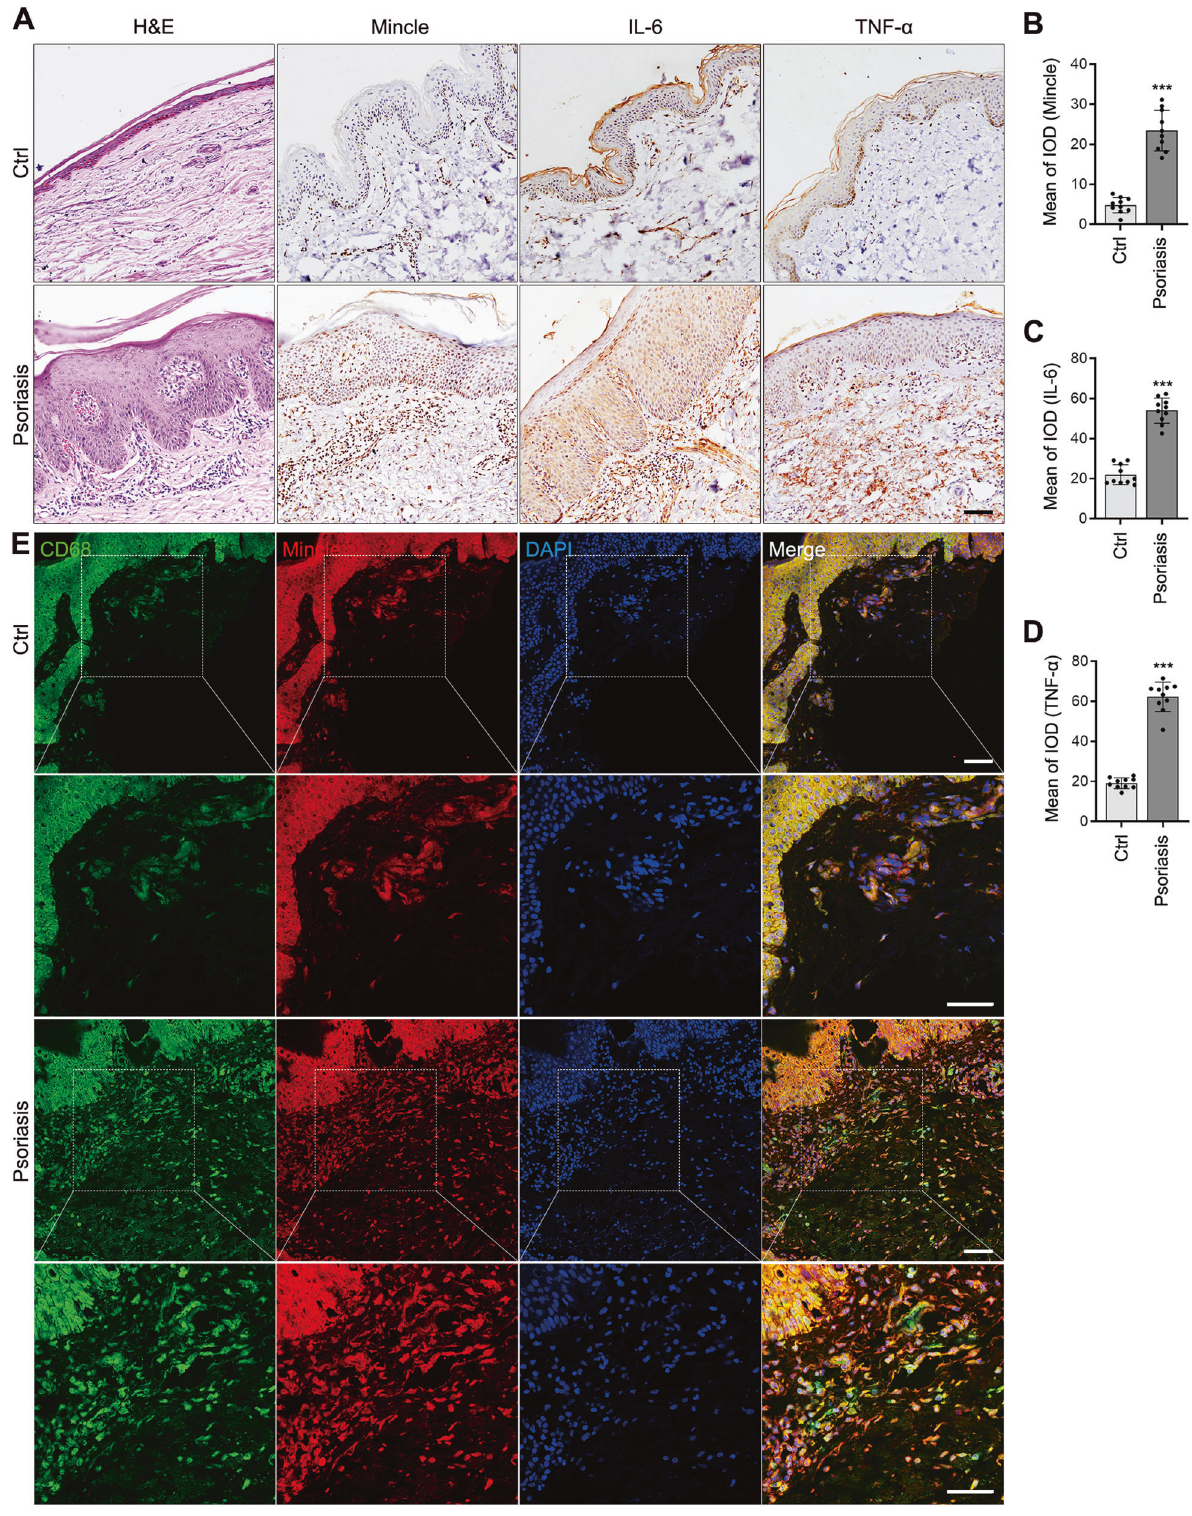
Fig. 1 Mincle is up-regulated and correlated with severe skin in fl ammation in patients with Psoriasis. A – D Representative images of H&E and immunohistochemical staining showing the skin lesions and expression of Mincle, IL-6 and TNF- α in normal person and patients ’ skins. E Representative images of immuno fl uorescence staining showing a markedly increased level of Mincle and CD68 in the skin of psoriasis patients. n = 10 in each group. *** P < 0.001 vs.